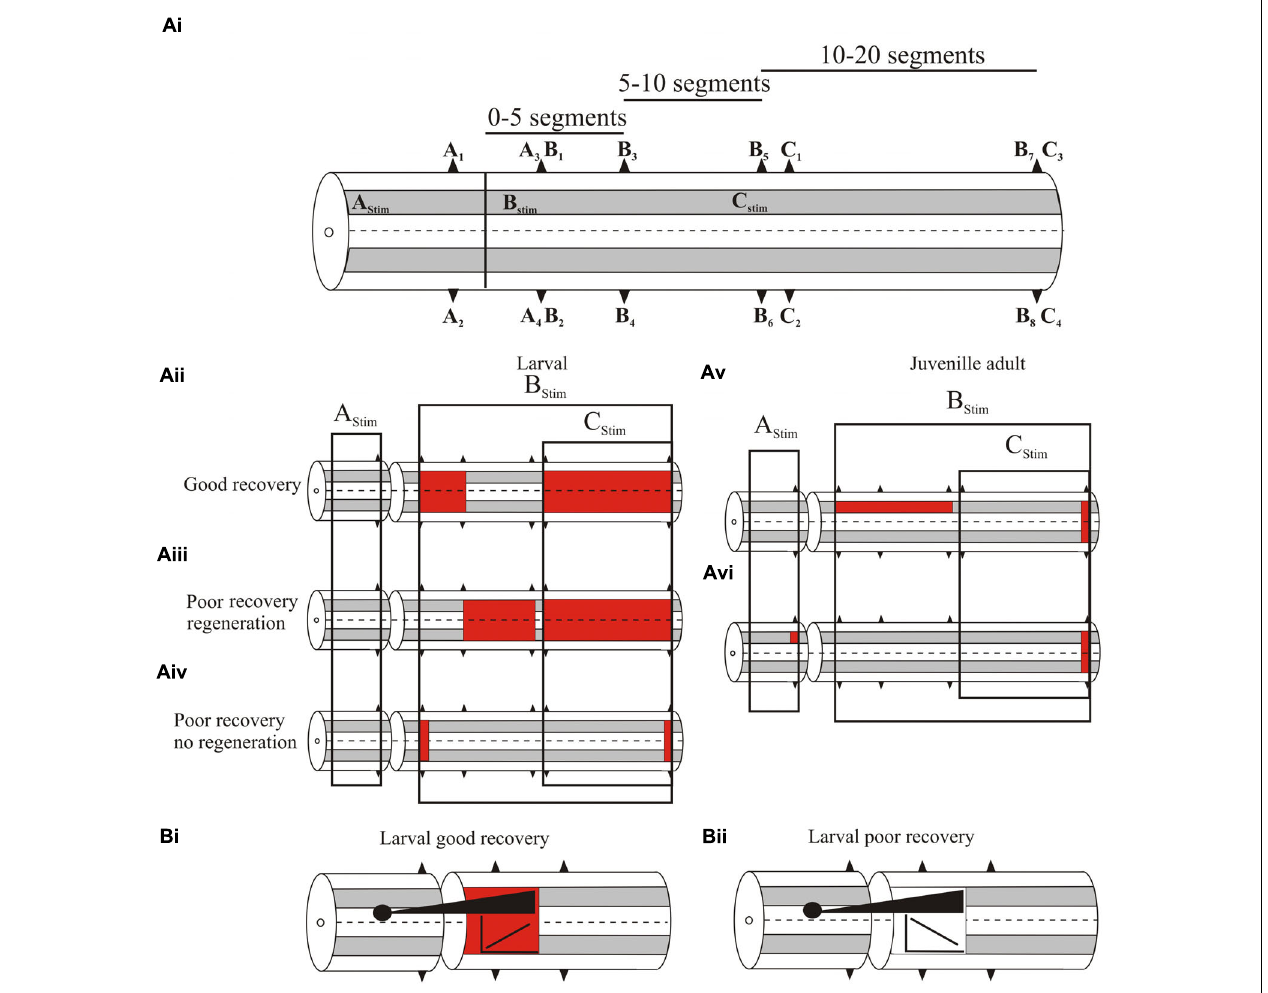
FIGURE 3 | (Ai) Experimental approach to examine changes in spinal cord excitability. A 1 –C 4 are ventral root locations along the body relative to a lesion site (or where the lesion would be in an unlesioned spinal cord). A 1 –A 2 are ipsilateral or contralateral ventral root responses recorded one segment above the lesion in response to stimulation three segments above the lesion (A Stim ); A 3 and A 4 are ipsilateral and contralateral responses, respectively, evoked by A Stim two segments below the lesion site. B 1 –B 8 are ventral root locations 2–20 segments below the lesion site (B 1 / 2 , 2 segments below; B 3 / 4 , 5 segments below; B 5 / 6 , 10 segments below B 7 / 8 , 20 segments below) ipsilateral to stimulation one segment below the lesion (B Stim ). C 1 − 4 are ventral root locations 10–20 segments below the lesion site (C 1 / 2 , 11 segments below; C 3 / 4 , 20 segments below) in response to stimulation 10 segments below the lesion (C Stim ). (Aii) Changes in excitability in larvae that showed good recovery. The colored squares represent increased excitability for stimulation in the regions indicated by the boxes. (Aiii) Excitability changes in